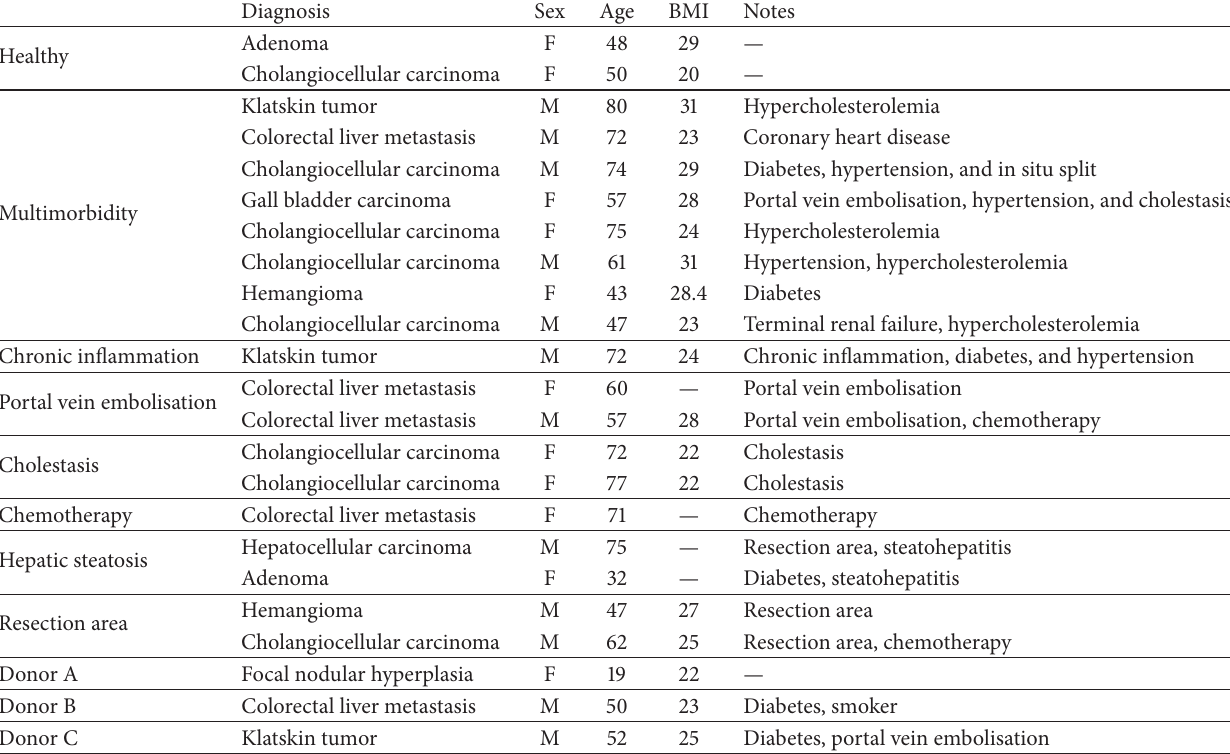
Table 1: Anamnesis data of investigated